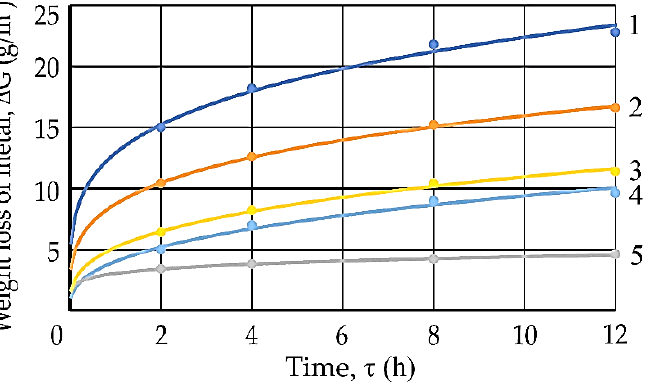
Figure 5. Dependences of corrosion processes for the most characteristic modes: 1 — S r = 1.5%,  = 2.9, W r = 2%; 2 — S r = 1.5%,  = 1.25, W r = 2%; 3 — S r = 0.98%,  = 1.35, W r = 15%; 4 — S r = 2%,  = 1.01, W r = 2%; 2—S r = 1.5%, α = 1.25, W r = 2%; 3—S r = 0.98%, α = 1.35, W r = 15%; 4—S r = 2%, α = 1.01, W r = 2%; 5 — S r = 1.5%,  = 1.15, W r = 30%. W r = 2%; 5—S r = 1.5%, α = 1.15, W r = 30%.